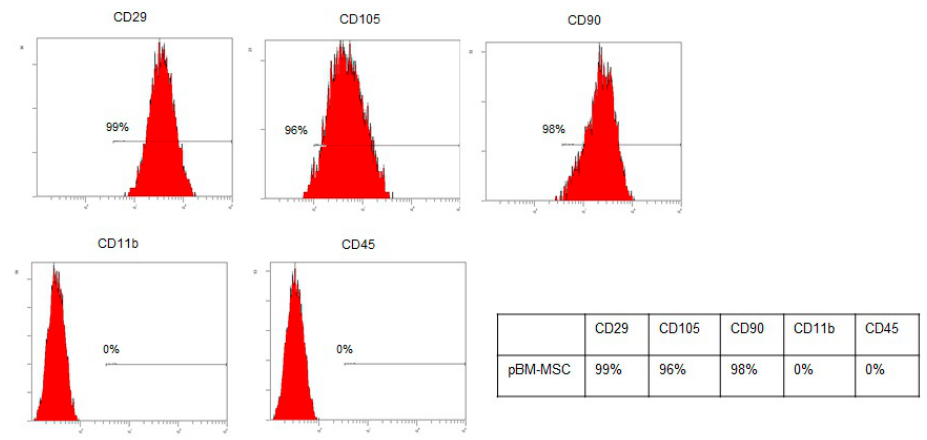
Figure 2. Percentage of antigen surface expression of pBM-MSCs after 30 day of incubation on bilayer electrospun matrices (EL-Ms) patches at 37 °C, 5% CO 2 .